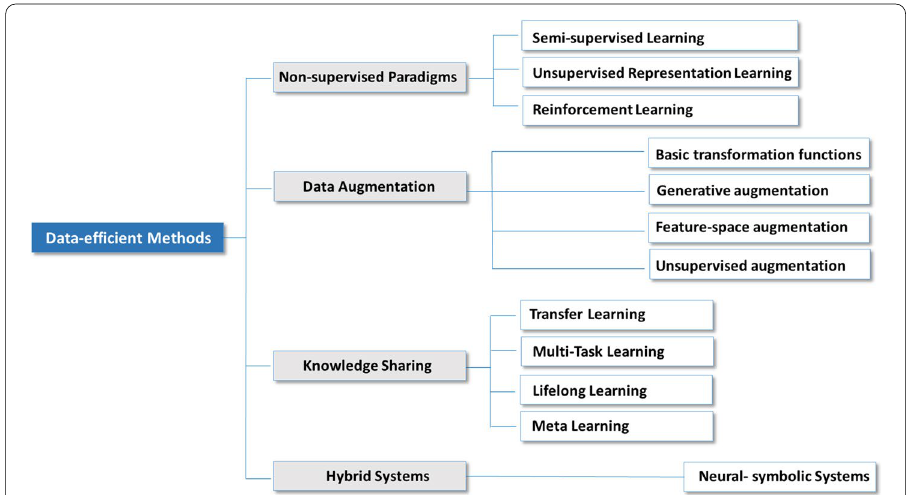
Fig. 5 Taxonomy of data-efficient methods, while many methods lie in the intersections of multiple categories they are grouped by where they are reviewed in this